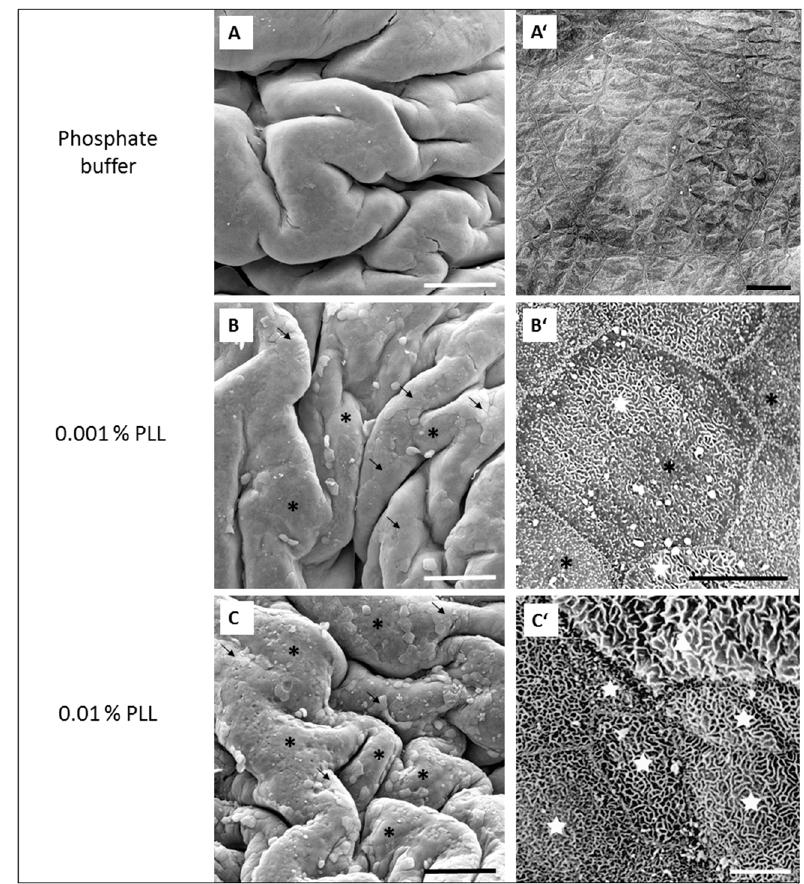
Figure 5. Representative SEM micrographs of the urothelium at the end of the 15 min treatment period with phosphate bu ff er ( A and A’ ), with 0.001% PLL (30–70 kDa) ( B and B’ ), or with 0.01% PLL (30–70 kDa) ( C and C’ ) in ex vivo experiments. Images ( A’ , B’ and C’ ) show key features of the urothelium at higher magnification. Image A shows intact urothelium and image A’ shows polygonal terminally di ff erentiated superficial cells (umbrella cells) with typically scalloped apical plasma membrane composing luminal surface of intact urothelium. In images B and C , the majority of the urothelium is desquamated (black asterisks) and in only some areas are umbrella cells still present (black arrows). In images B’ and C’ , desquamated areas of the urothelium are presented under higher magnification, where cells with microvilli (black asterisks in B’ ) and ropy ridges of apical membrane (white stars in B’ and C’ ) are exposed on urothelial surface due to desquamation of umbrella cells. Only individual umbrella cells still remain on the urothelial surface after such treatment (white triangle in C’ ). Scale bars: 200 µ m ( A , B , C ), 20 µ m ( A’ ), and 10 µ m ( B’ , C’